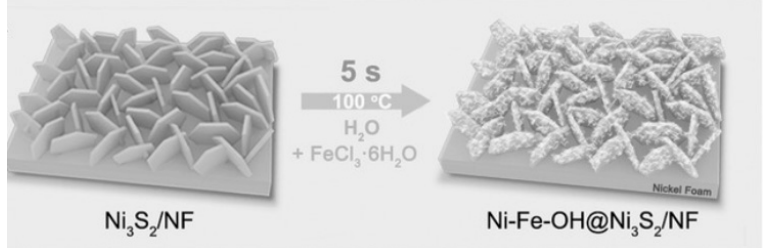
Figure 11. Ultrafast Ni–Fe ‐ OH@Ni 3 S 2 /NF preparation at 100 °C by a 5 sec immersion of Ni 3 S 2 /NF in a preheated aqueous solution with Fe 3+ . Reproduced from [41], with permission from John Wiley and Sons, copyright 2017.